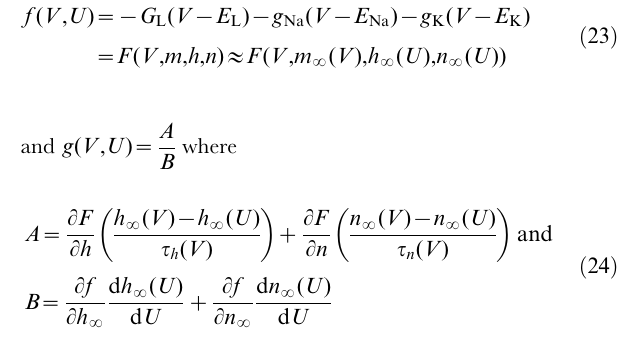
where L F = L h and L F = L n are evaluated at h ? ( U ) and n ? ( U ) . nullclines, i.e. the curves where d V = d t ~ 0 and d U = d t ~ 0 . The two-dimensional dynamics. In Figure 8 we use arrows in the phase